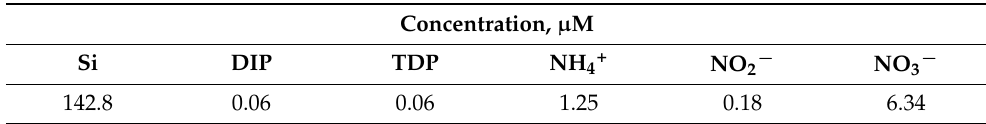
Table 4. The concentration of nutrients in conventionally clean underground waters of the Ayazma- Chokrak